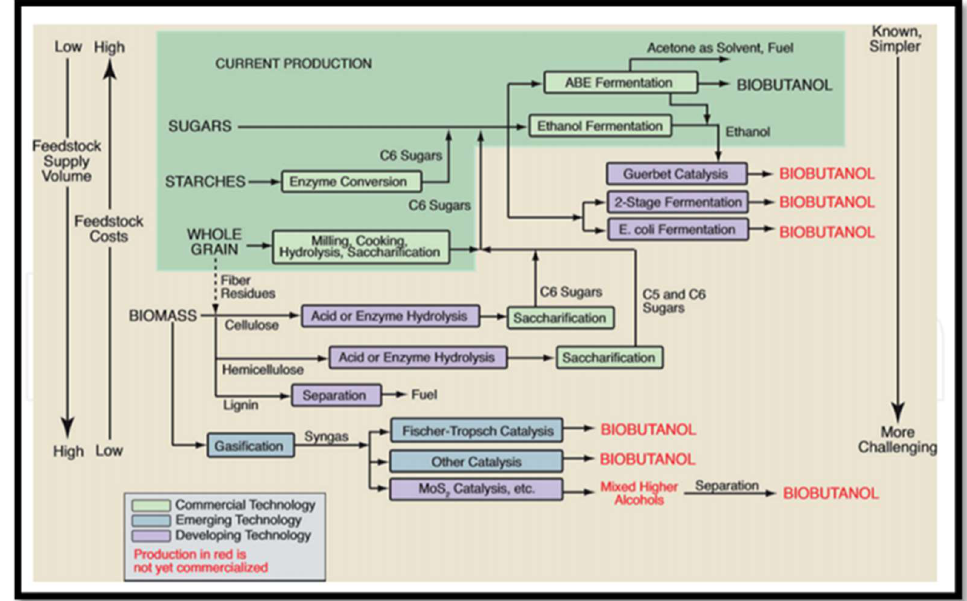
Figure 4. Biobutanol production process